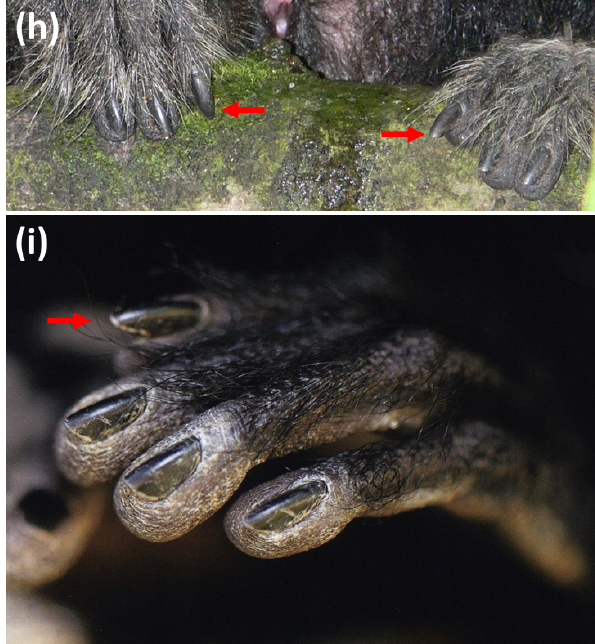
Figure 1. Conspicuous nail appearance on the second pedal digit in individuals of the genus Pithecia . (a) Engraving of Pithecia monachus (photo taken from an engraving in Lydekker (1893– 1894) owned by the senior author); (b) Pithecia monachus , juve- nile male (see Bartecki and Heymann, 1987, for information on this in individual), (© Ursula Bartecki); (c, d) Pithecia pithecia , juvenile male from the Cologne Zoo (© Constanze Ohlendorf); (e) Pithecia monachus (ZMB_Mam_35984); (f) Pithecia monachus (ZMB_Mam_46147); (g) Pithecia pithecia (ZMB_Mam_38456); (h) Pithecia inusta , juvenile female (© Laura K. Marsh; detail from a photo in Marsh, 2014); (i) Pithecia pithecia , adult male (© Thomas Marent; detail from a photo in Marent and Jantschke,